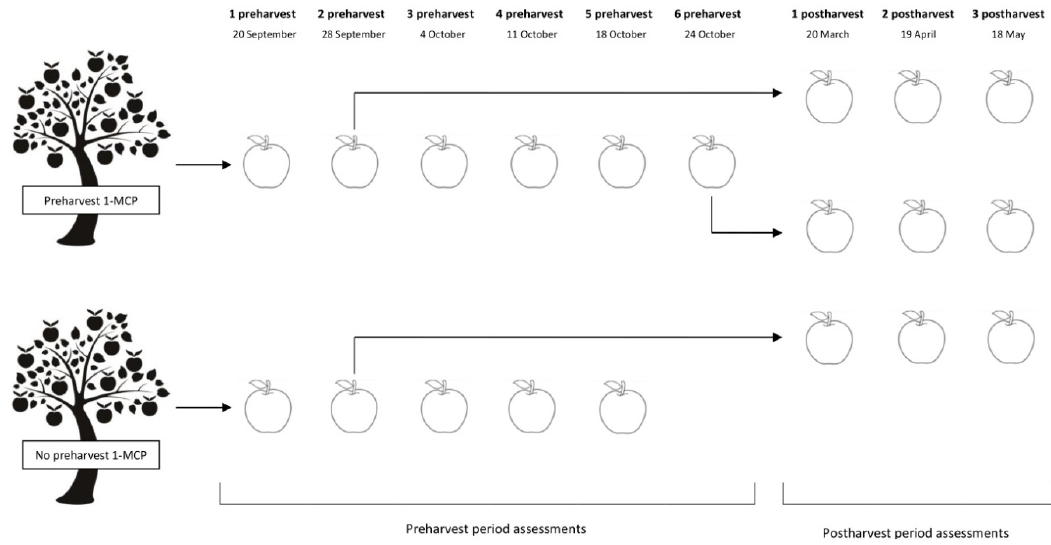
Figure 1. The scheme of the experiment.